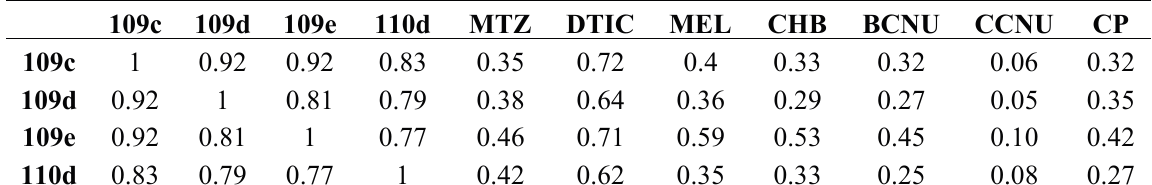
Table 2. Results of Matrix COMPARE (P values) for NCEs 109c – e , 110d , with selected standard agents. DTIC, 5-(3,3-dimethyl-1-triazeno)imidazole-4-carboxamide ( 3 ); MEL, melphalan; CHB, chlorambucil; BCNU, 1,3-bis(2-chloroethyl)-1-nitrosourea;